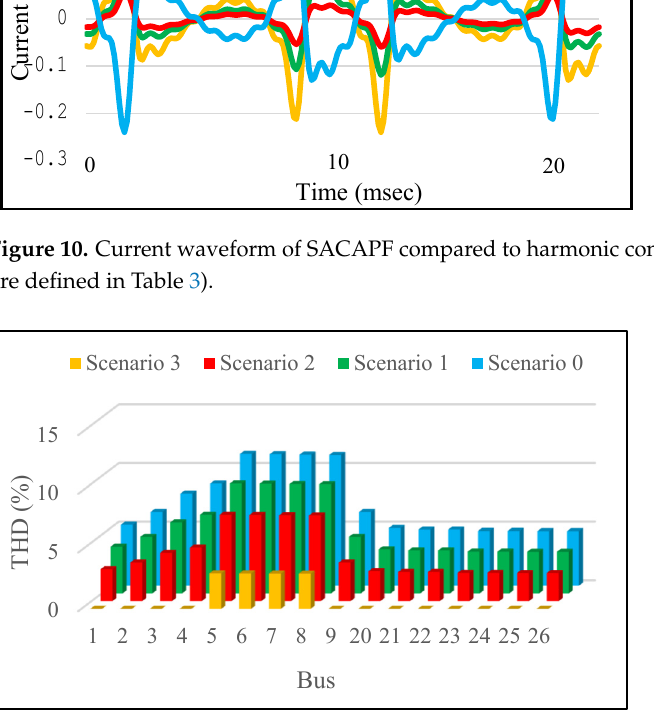
Figure 10. Current waveform of SACAPF compared to harmonic content of nonlinear load (scenar- ios are defined in Table 3).